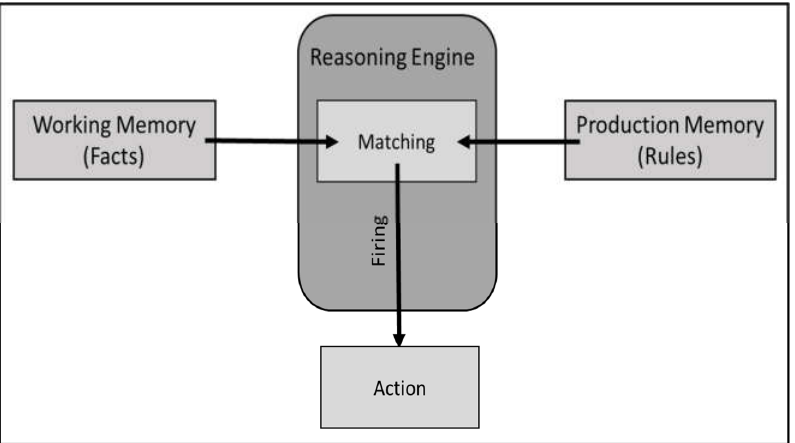
Figure 4. Rule Management System components.